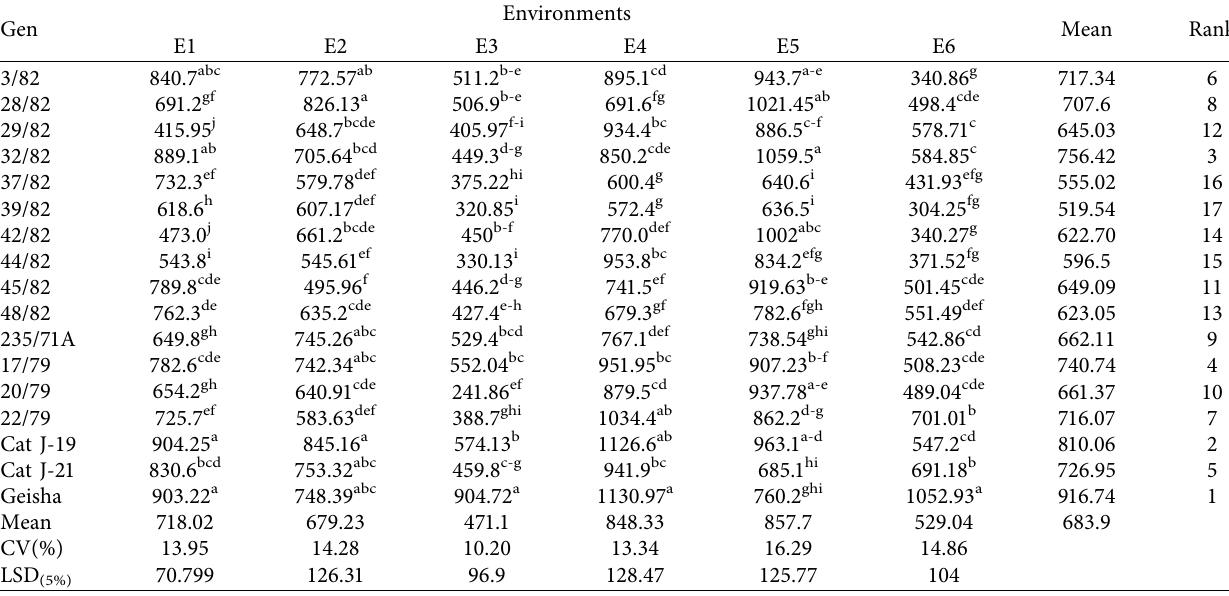
Table 5: Mean bean yield (kg ha − 1 ) of 17 coffee genotypes tested across six environments during 2016/17 and 2017/18 cropping season at different locations over years.